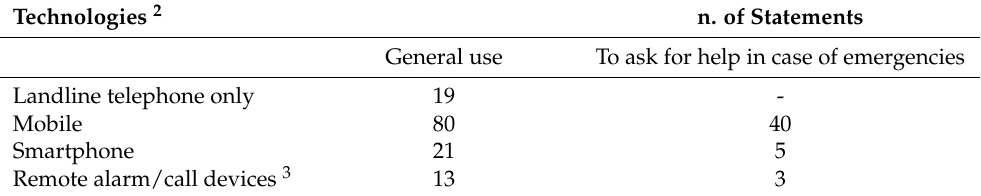
Table 5. Independent use of technologies: in general, and for emergencies 1 .